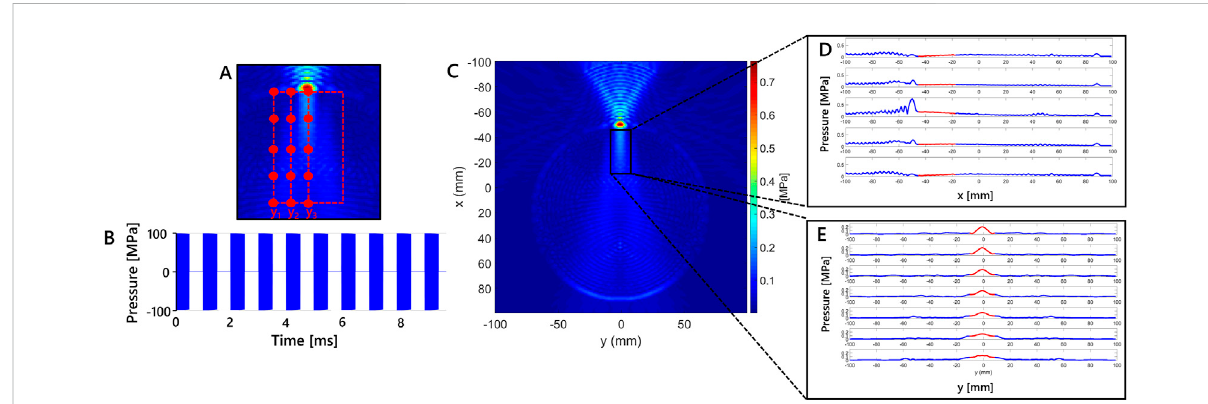
FIGURE 4 Macroscale model results showing a 2D grid color map of maximum pressure due to the tFUS stimulation for modelled skull thickness of 5.4 mm. (A) Enlargement of the region of interest. The 15 points selected considering three different y-coordinates (i.e., y 1 = − 10.19, y 2 = − 5.56 and y 3 = − 0.92 mm) in simulation at 5.4 mm of skull thickness are shown. (B) Schematics of the stimulation waveform used in the simulation study. Each 1 msburstofsonicationpulsesoperatingatapulserepetitionfrequencyof500 Hzisasinusoidalwaveat250 kHz. (C) Maximumpressure(MPa) inx-yplaneforthesimulationat5.4 mm, (D) Maximumpressurevariationalongxfor fi ve fi xedvaluesofy-coordinate,redlinehighlightstheregionof interest along x. (E) Maximum pressure variation along y for seven fi xed values of x-coordinate, red line indicates highlights the region of interest along